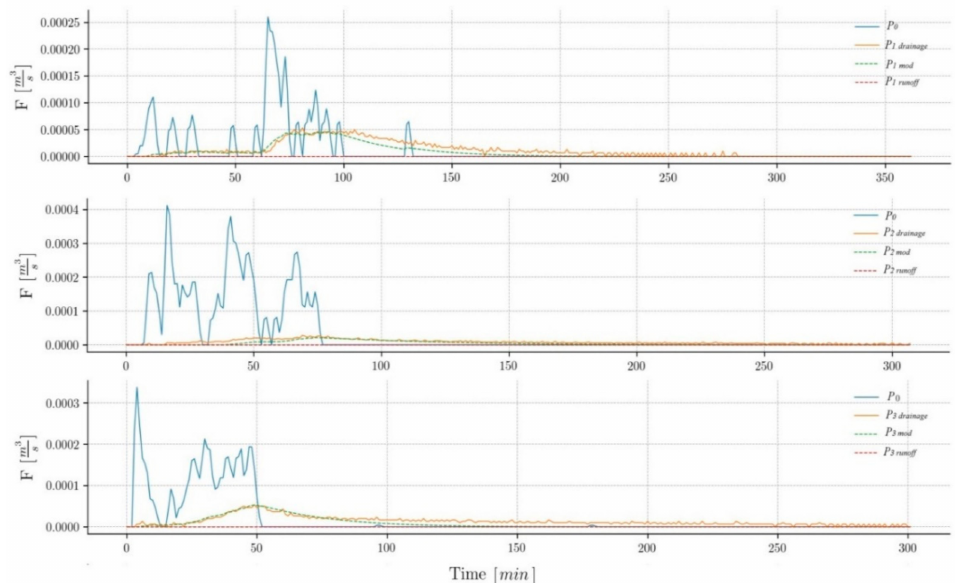
Figure3. Hydrologicalresponseofthepermeablepavements. P 0 = FlowgeneratedbyP0;Pi drainage = Flow generated by Pi (measured); Pi mod = Flow generated by Pi (modeled); Pi runoff = Runoff generated by Pi (modeled).